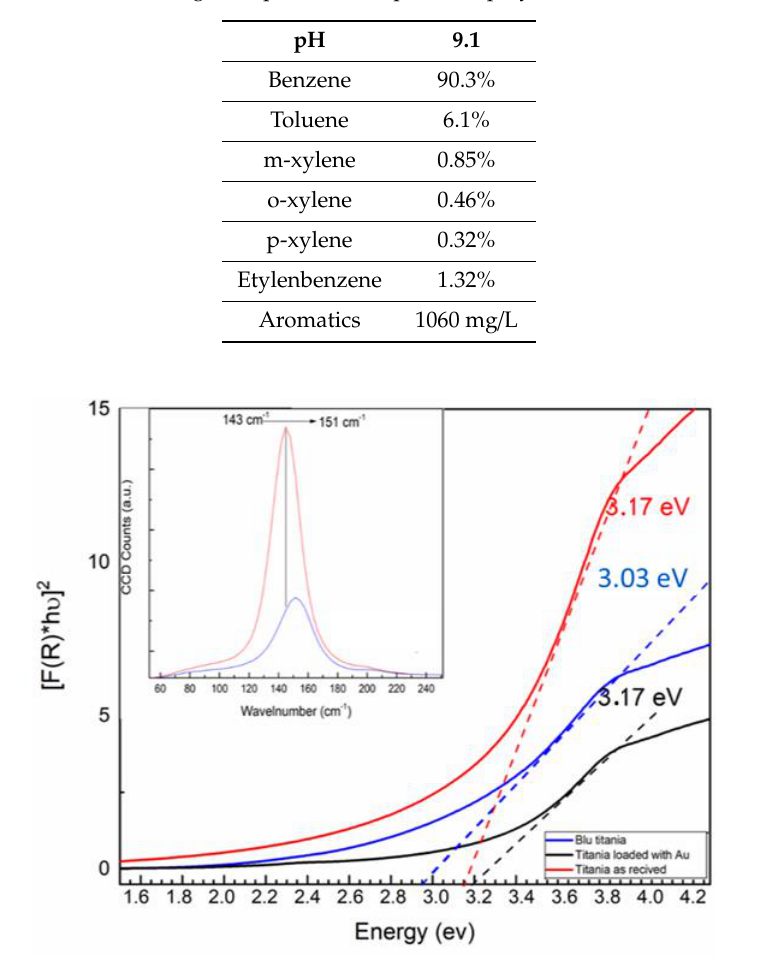
Figure 20. Energy bandgap calculation by Kubelka-Munka transformation for the three catalyst. Inset: a zoom of the lower energy region was set up the Au NPs adsorption (right side). In the inset is reported the micro-Raman spectra of as prepared TiO 2 (red line) and of blue Titania (blue line) with a zoom of the TiO 2 E g anatase peaks before and after the laser treatment.